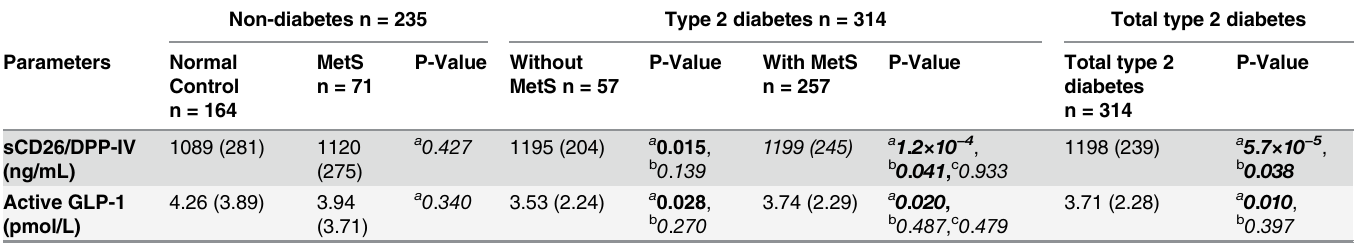
Table 2. Comparison of fasting serum levels of sCD26/DPP-IV and active GLP-1 between normal, non-diabetic metabolic syndrome, type 2 diabe- tes mellitus subjects with and without metabolic syndrome and total type 2 diabetes mellitus. Non-diabetes n = 235